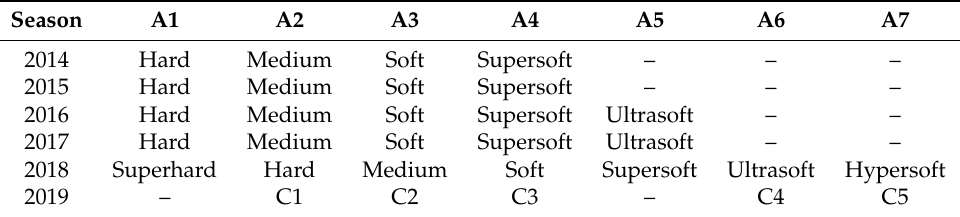
Table 2. Overview of available tire compounds in the seasons 2014 to 2019. The column names are inspired by the 2019 season compound names, so as to enable comparison of the compounds over the years. A1 is the hardest compound, and A7 is the